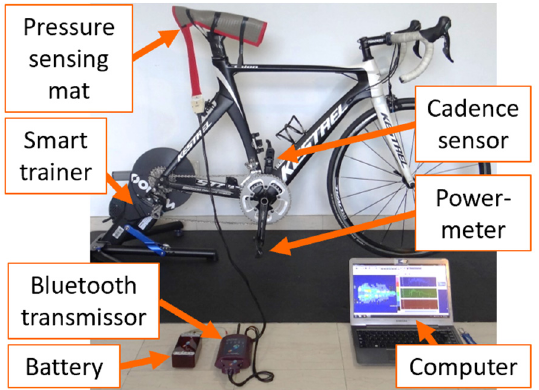
Figure 4. Setup for the characterization of the pressure in contact areas.